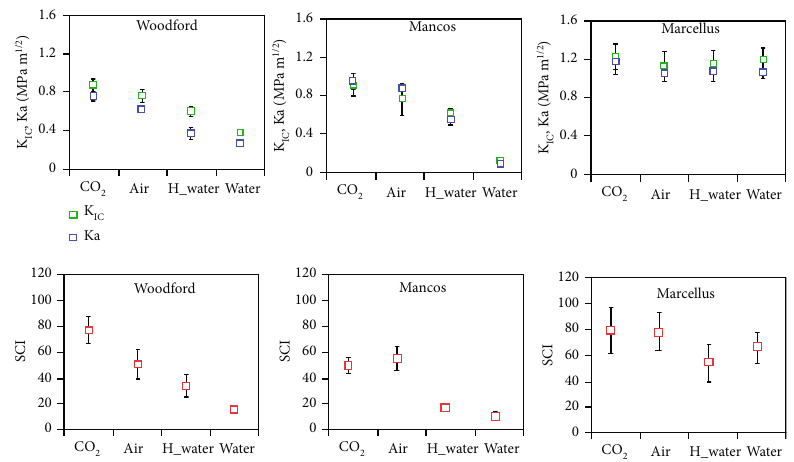
Figure 16: Testing results from Chen et al. [19].